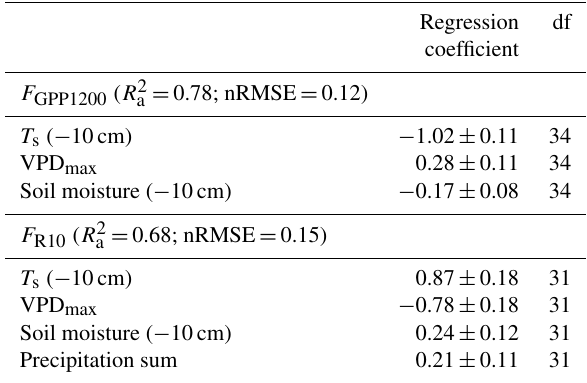
Table 5. Standardised regression coefficients ( ± standard error) for the explanatory variables of the linear regression model for EC- based F GPP1200 and F R10 . The adjusted coefficient of determina- tion ( R 2 a ), normalised root mean square error (nRMSE; RMSE di- vided by the range of response variable values), and degrees of free- dom (df) are also